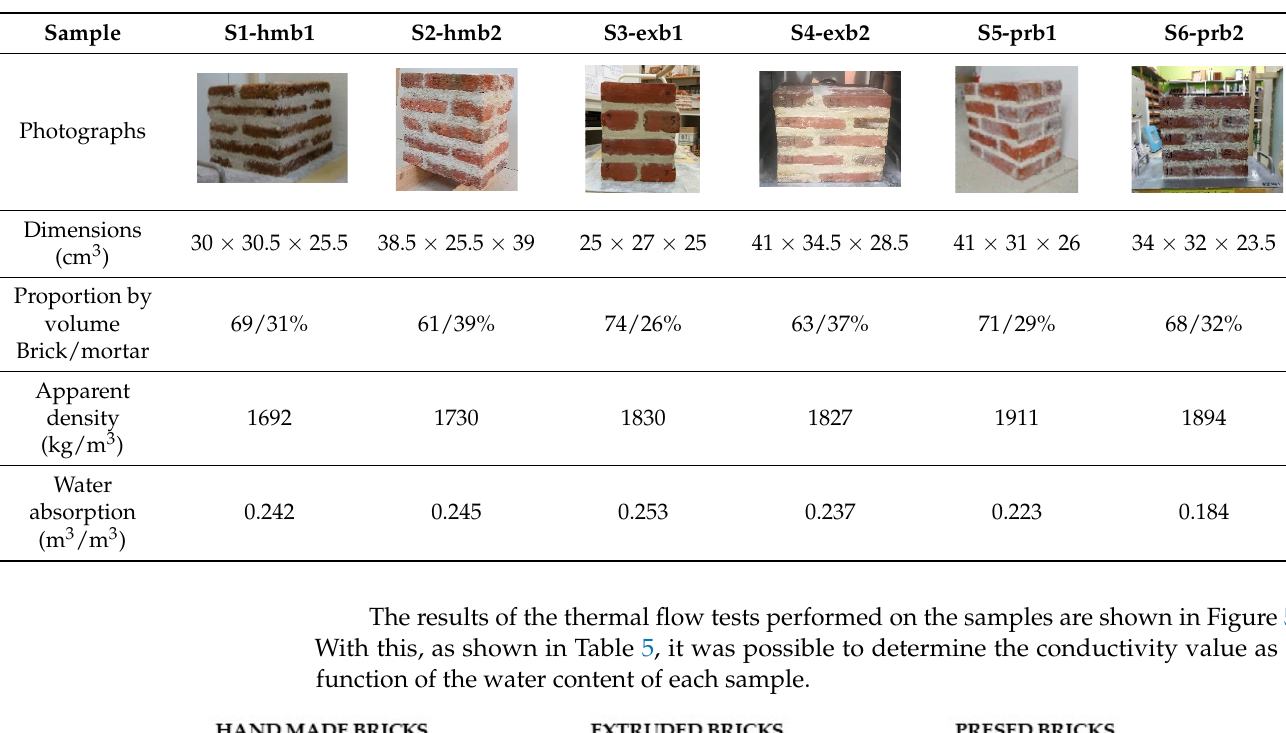
Table 4. Test results of test samples.